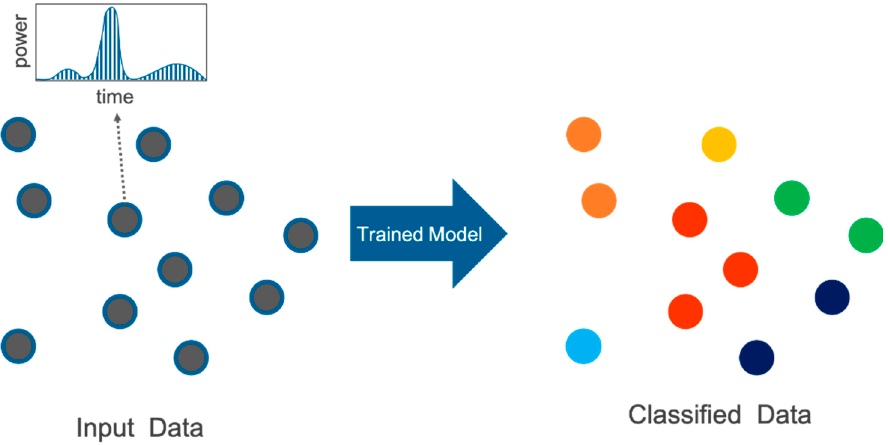
Figure 1. Overview of our proposed network (full-waveform network (FWNet)) for full-waveform light detection and ranging (lidar) data. Our FWNet predicts the class of each input data consists of waveform and its coordinate. The color of each point in the right figure is a class (land cover/land use).